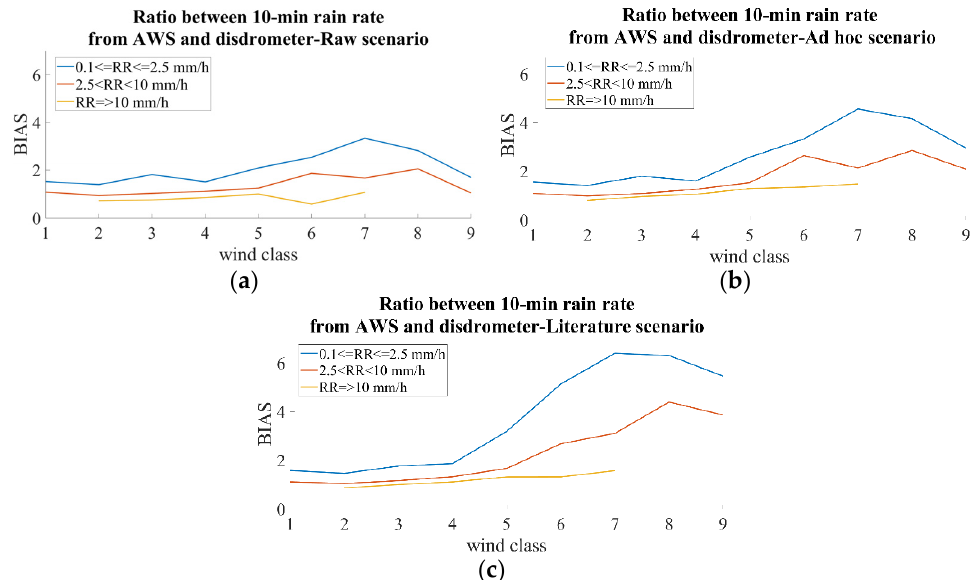
Figure 12. Behavior of BIAS score with respect to wind classes defined in Table 3 for raw ( a ), ad hoc ( b ) and literature scenarios ( c ). The results obtained for light-rain events (0.1 ≤ RR ≤ 2.5 mm h − 1 ), for moderate-rain events (2.5 < RR < 10 mm h − 1 ) and heavy-rain events ( ≥ 10 mm h − 1 ) are presented as blue, red and orange lines,